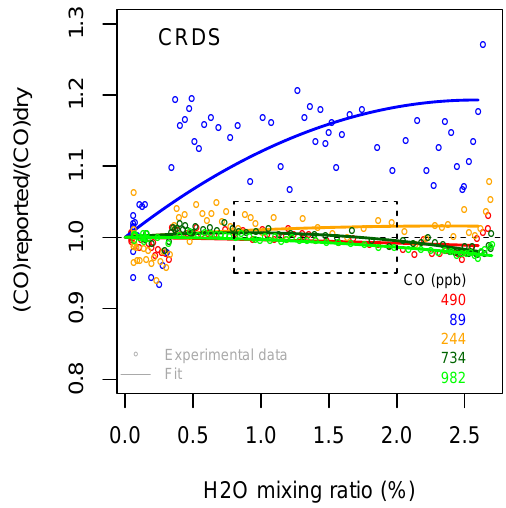
Fig. 9. Ratios of CO reported /CO dry mole fractions vs. water vapour mixing ratios of the CRDS instrument for different CO levels. The black dotted line indicates a perfect correction of the reported CO mole fraction. The box denotes conditions encountered during the ambient air comparison (see Sect.